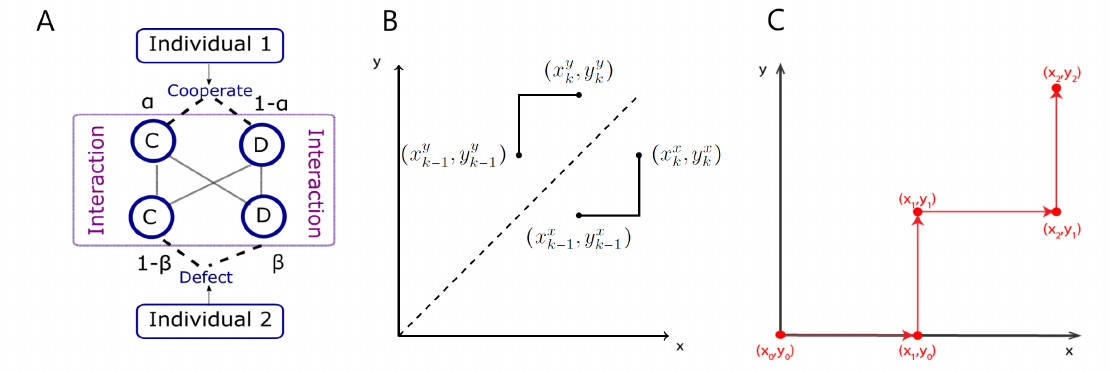
Figure 1. ( A ) A schematic representation of the effect of mistakes: individual 1 chooses to cooperate and individual 2 chooses to defect. However, under incompetence, individual 1 will cooperate only with probability α and individual 2 will defect only with probability β . Hence, the outcome of the interaction now depends on the probability distribution of mistakes. ( B ) A schematic representation of prioritised learning: we aim to define first an optimal direction in which the learning should start ( x and y direction represents strategies 1 and 2, respectively) and an n -step optimal sequence of ( x x ) if y direction is optimal). ( C ) An example of a learning path in the x direction. We optimal (or ( x y , y y k k start at ( x 0 , y 0 ) , then taking the first half-step in the x direction to ( x 1 , y 0 ) and a second half-step in the y direction to ( x 1 , y 1 ) . By design, we have to start at ( 0,0 ) and finish at ( 1,1 )